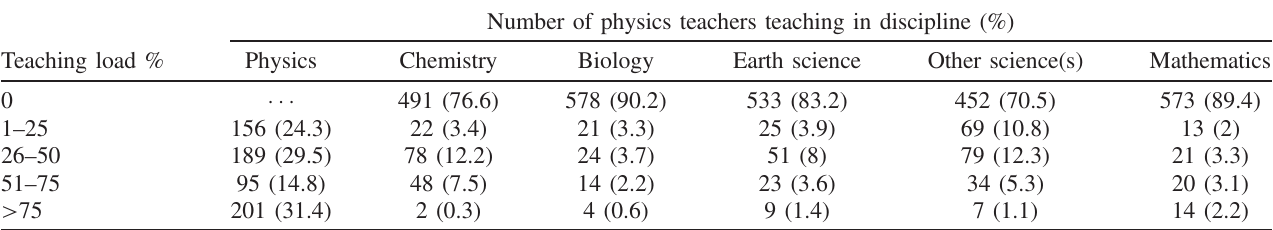
TABLE VII. Course load of the isolated physics teachers ( N ¼ 641